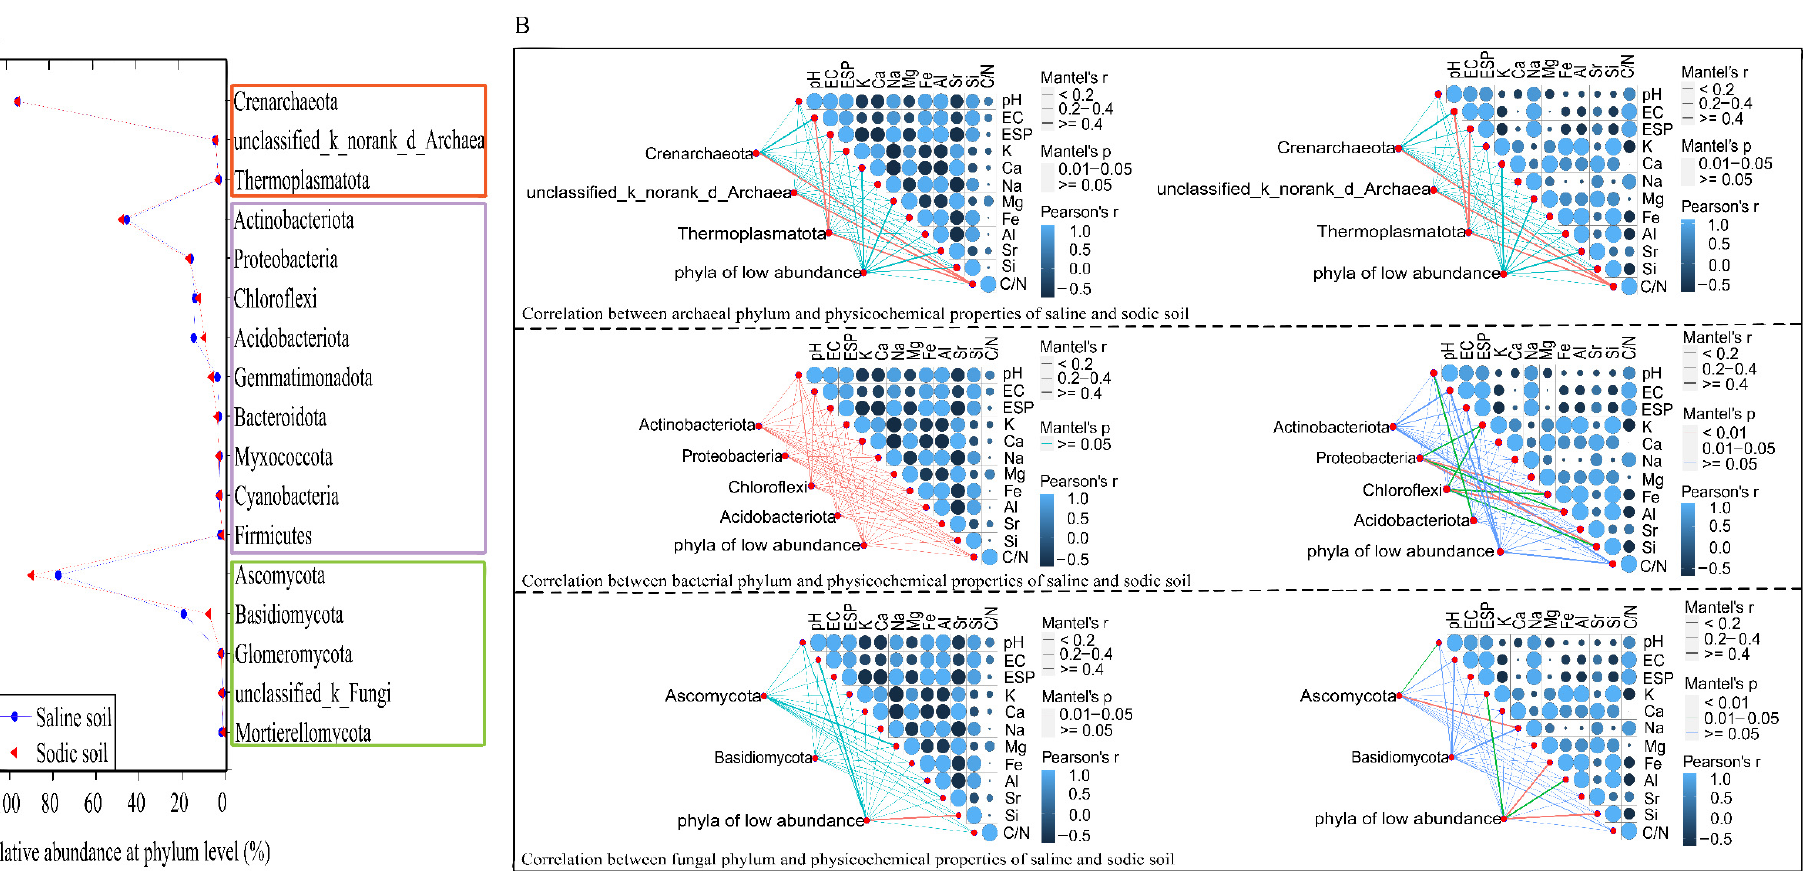
Figure 5. ( A ). The relative abundance of microbial communities at the phylum level, including archaeal (orange box), bacterial (pink box), and fungal (green box) communities; ( B ). Relative abundance of microbial communities at the phylum level is related to soil environmental factors (saline soil at the left and sodic soil at the right) by partial Mantel test (phyla of low abundance represent archaeal microbial communities with relative abundance less than 1%, the relative abundance of bacterial and fungal microbial communities less than 5%); edge width corresponds to the Mantel’s r statistic for the corresponding distance correlations, and the edge color denotes the statistical significance based on 9999 permutations.